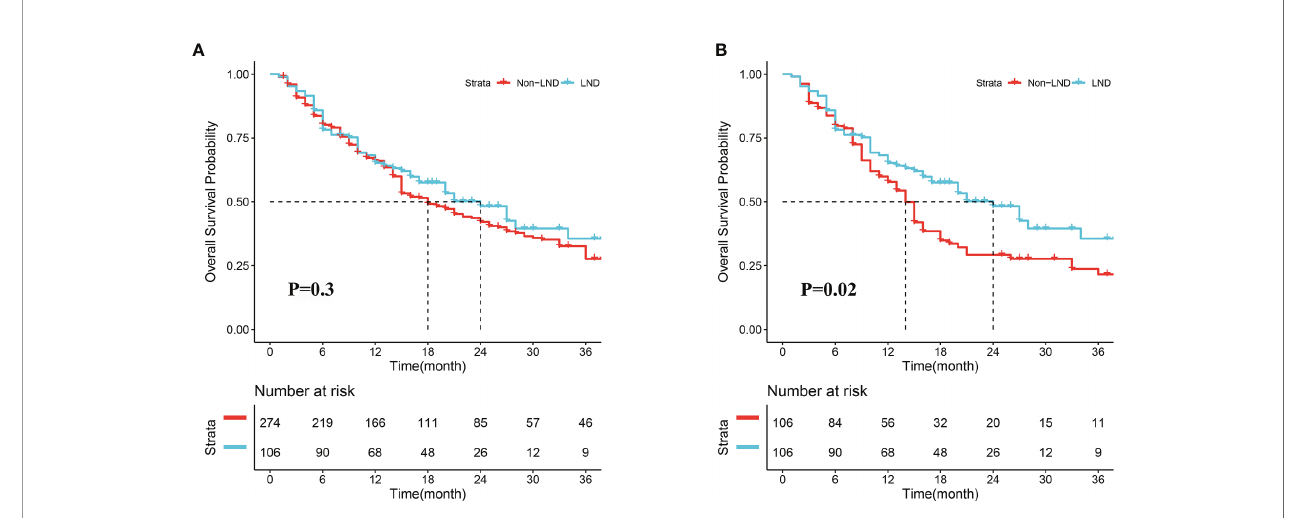
FIGURE 2 | Overall survival of patients receiving lymph node dissection (LND) or not before (A) and after propensity score matching (B) .